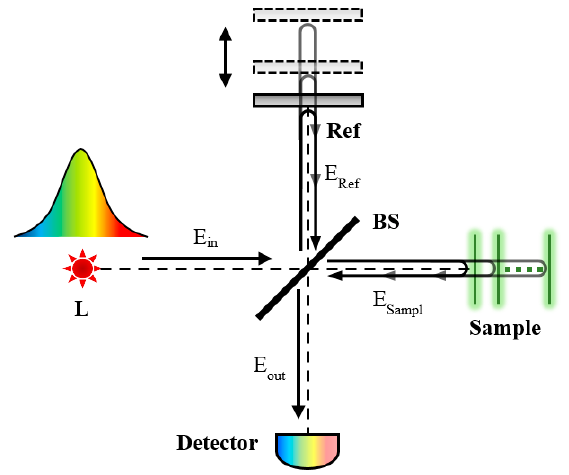
Figure 1. Schematic diagram of a time-domain optical coherence tomography (TD-OCT) system. L—low-coherence light source; Ref—reference mirror; BS—beam-splitter.